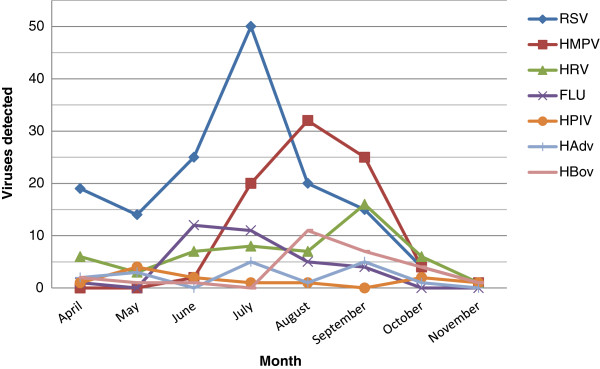
Monthly numbers of samples positive for the different viruses from the subjects studied.